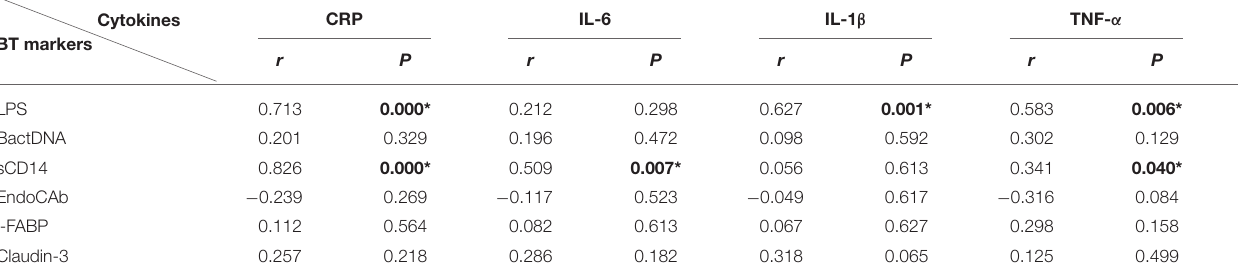
TABLE 2 | Relations of bacterial translocation markers to cytokines in ScZ-Ag group. Cytokines BT markers